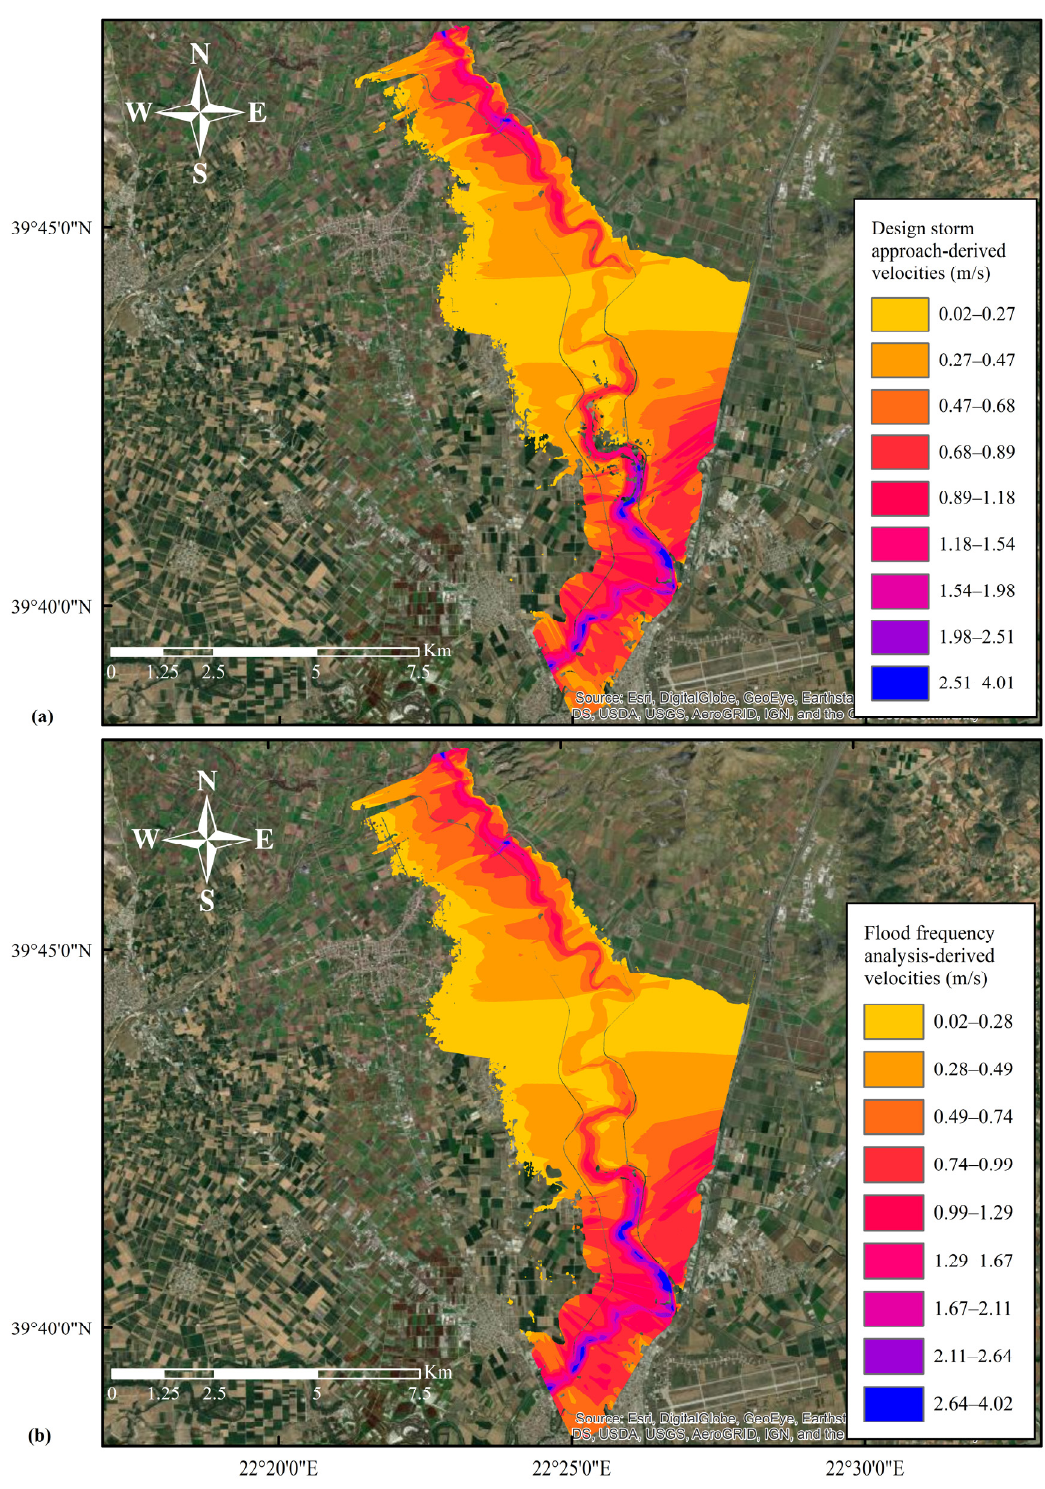
Figure 9. Flow velocity (m/s) distribution for the ( a ) design storm approach and ( b ) continuous simulation and flood frequency analysis approach downstream of the catchment.